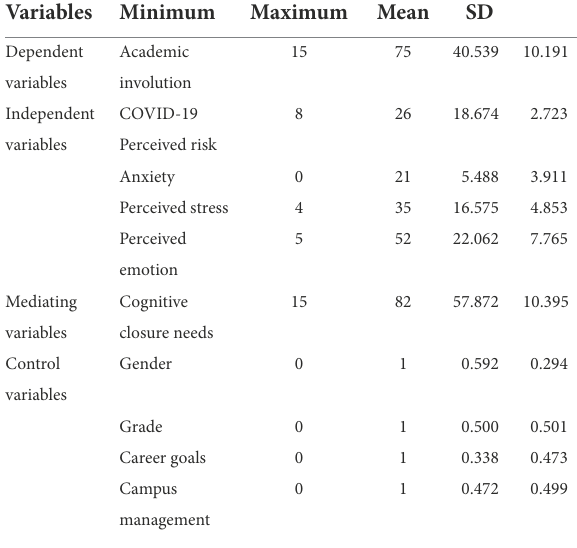
TABLE 1 Descriptive statistical analysis of